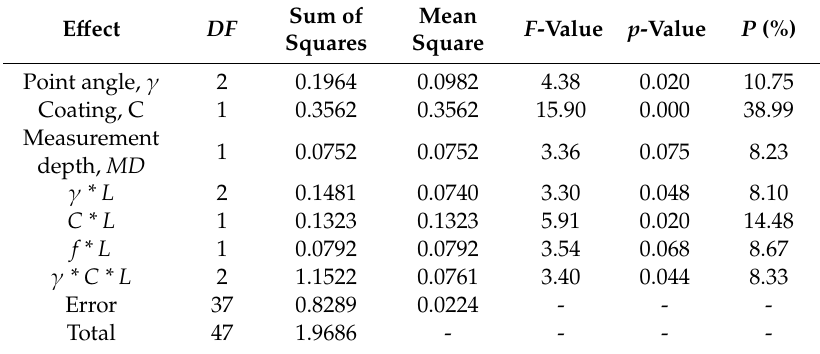
Table 5. Analysis of the last iteration for the ANOVA of Ra